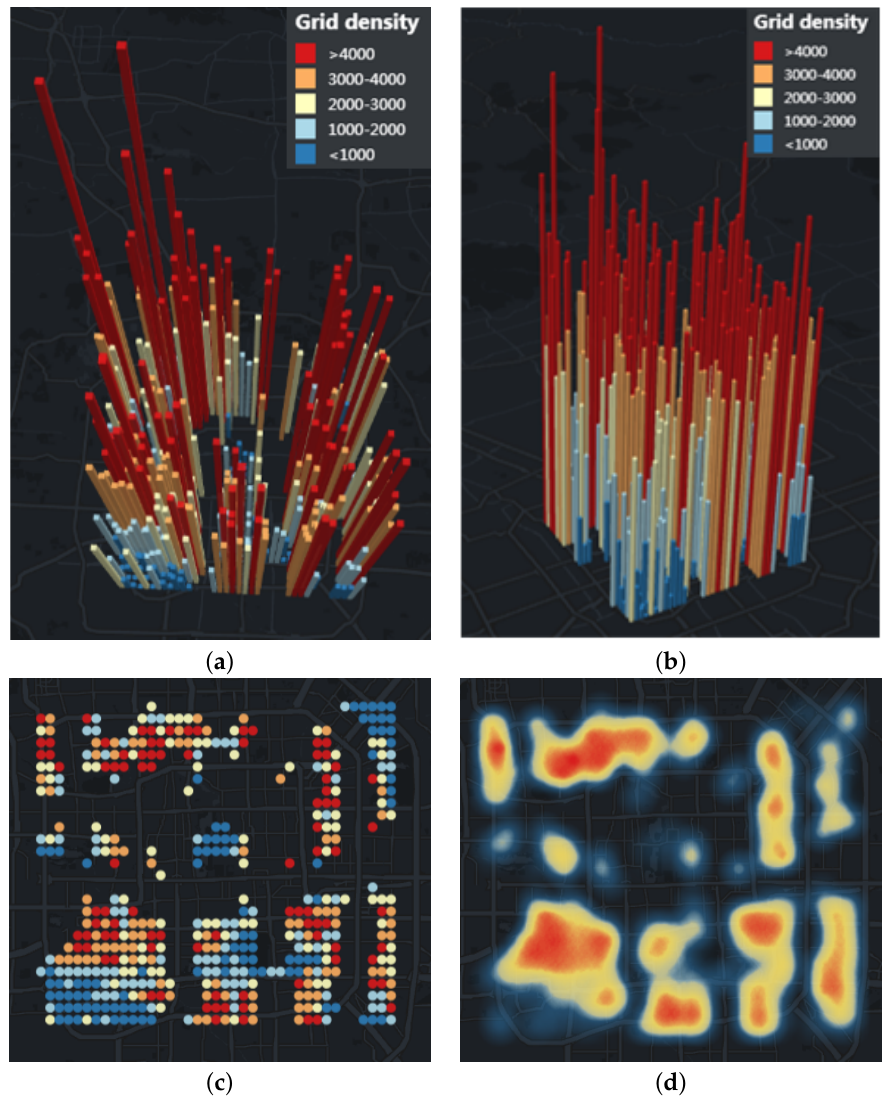
Figure 8. Density visualization of uncovered AP in central Beijing. ( a ) 3D density visualization; ( b ) 3D density visualization at 45 degrees; ( c ) 2D density visualization; ( d ) Heat